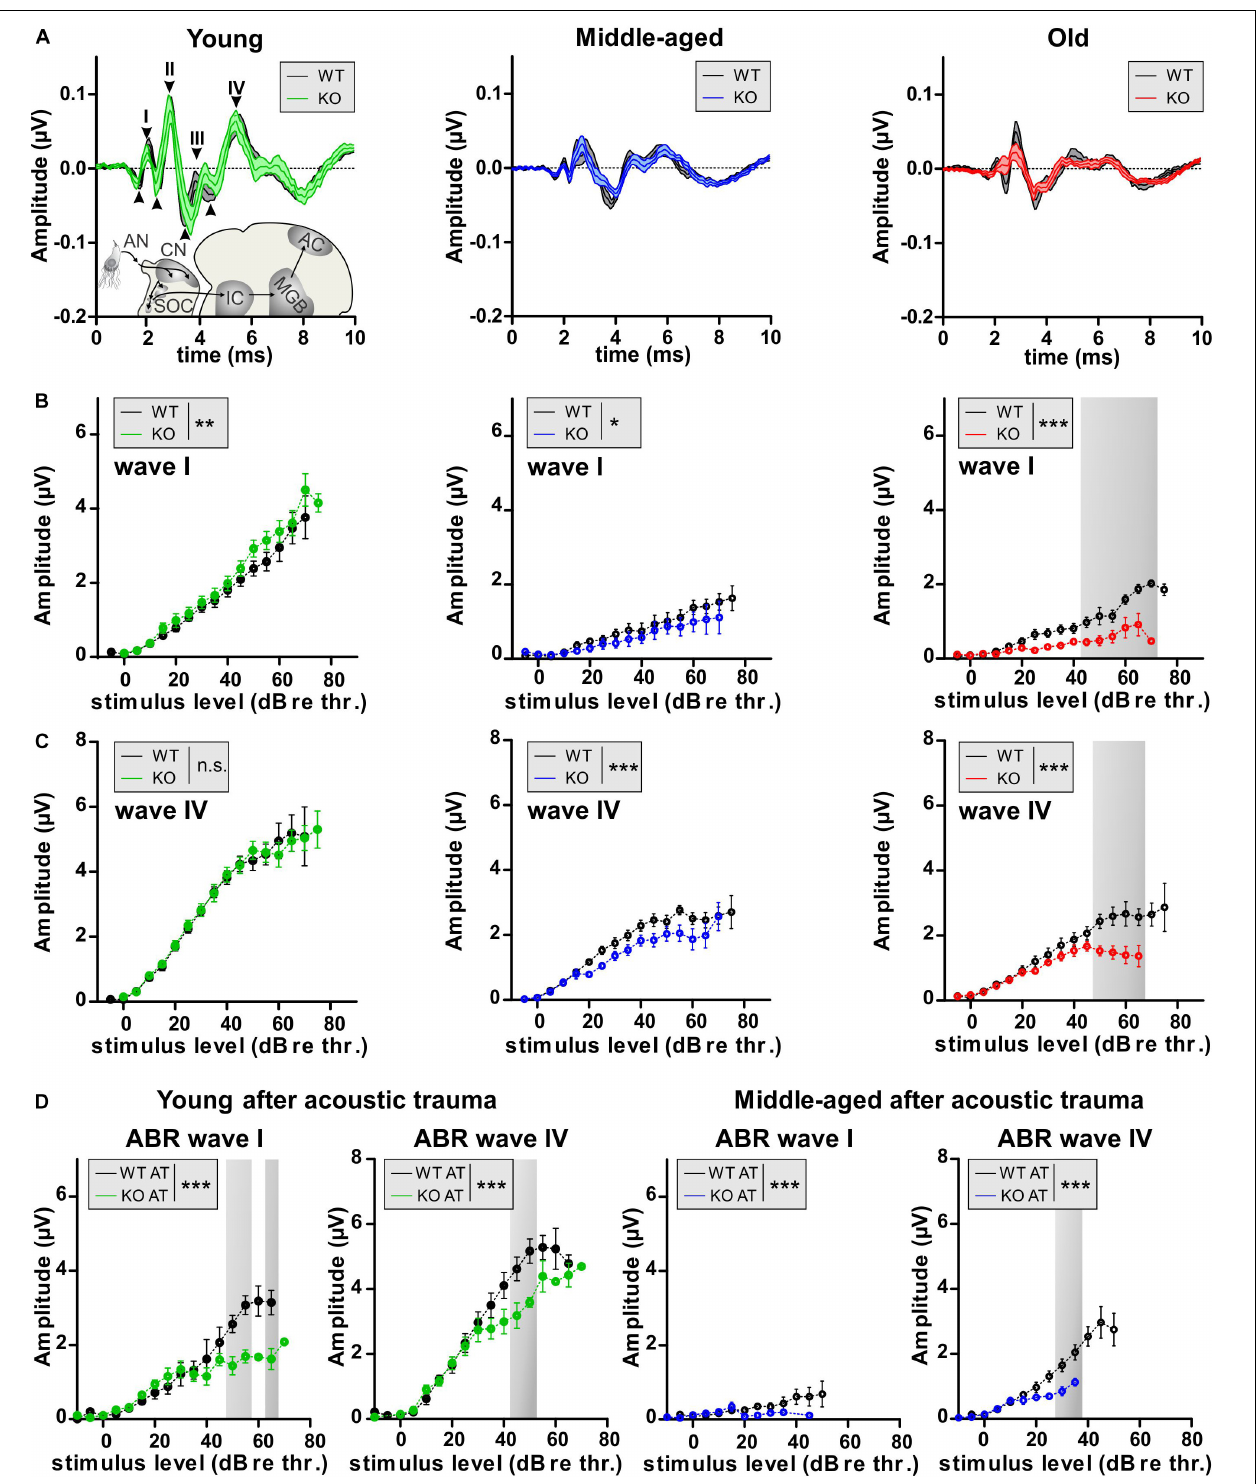
FIGURE 5 | Auditory nerve and brainstem response amplitudes in GC-A WT and KO mice. (A) ABR waveform, indicating ABR wave I peak-to-peak amplitude 40 dB above the hearing threshold. Mean ± SEM. (B) The noise-burst evoked ABR wave I as a measure of the summed activity of auditory-nerve fibers assessed to investigate the effect of GC-A gene disruption on auditory-nerve responses in mice before noise exposure. Noise-burst-evoked ABR wave I amplitude growth functions were affected in GC-A KO mice (young: green, middle-aged: blue, old: red) in all three age groups compared with WT mice (all ages: black) before